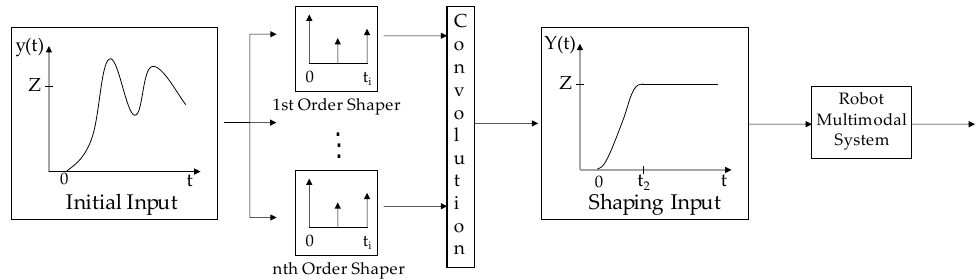
Figure 12. Multimodal input shaping control principle.